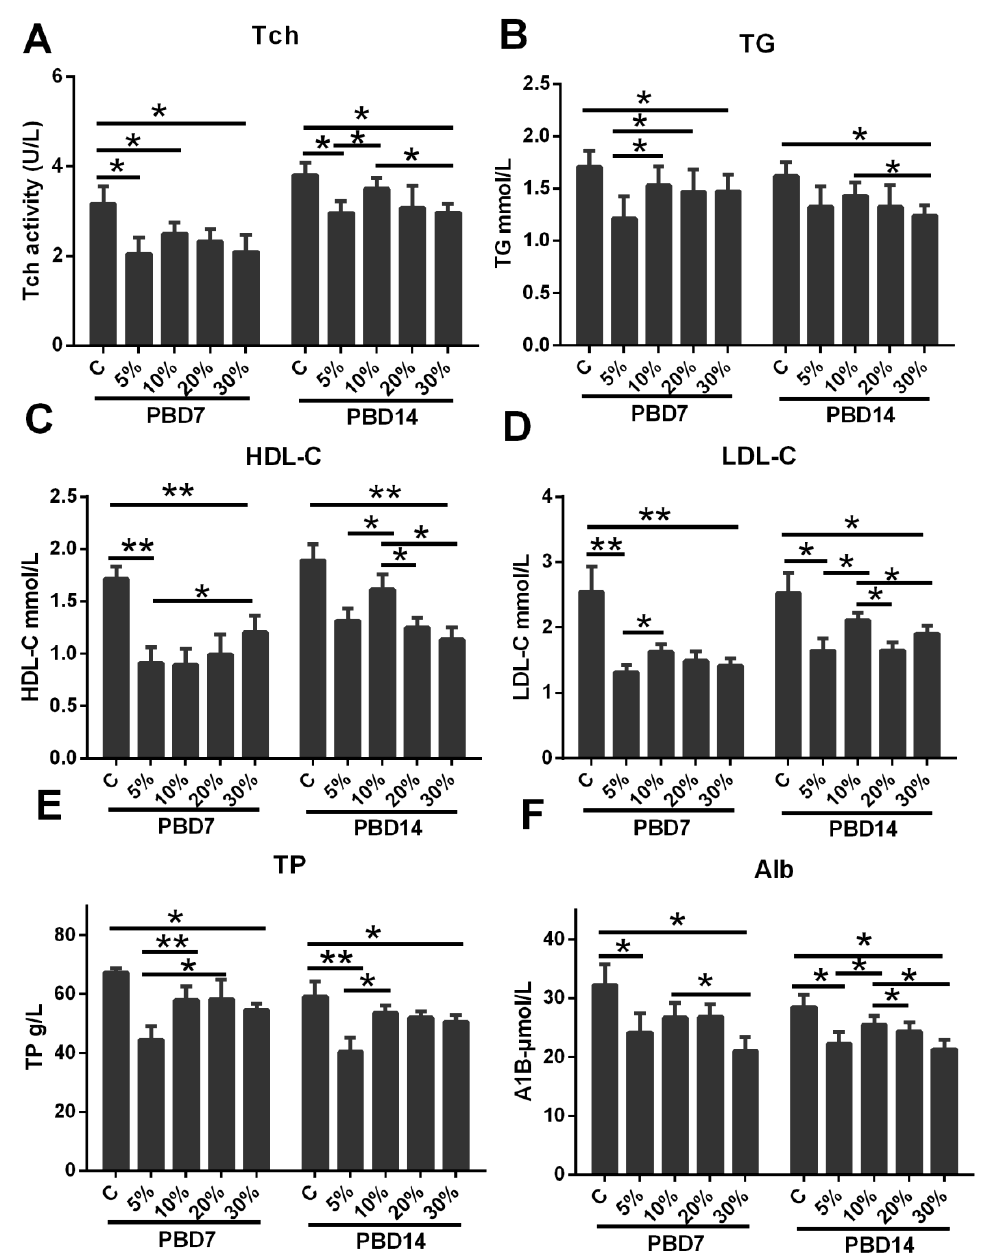
Figure 4. The effect of different carbohydrate–fat ratios on the blood lipid and protein level in plasma 7 and 14 days post-burn. At 7 days post-burn, Tch ( A ), TG ( B ), HDL-C ( C ), LDL-C ( D ), and TP ( E ) were significantly lower compared with the normal group, and the 10% group was remarkably higher in TG ( B ), HDL-C ( C ), and TP ( E ) than the 5% group. At 14 days post-burn, the 10% group had significantly higher Tch ( A ), LDL-C ( D ), HDL-C ( C ), and AIB ( F ) than the 5%, 20% and 30% groups. N = 6 per group, * p < 0.05, ** p < 0.01, PBD: post-burn